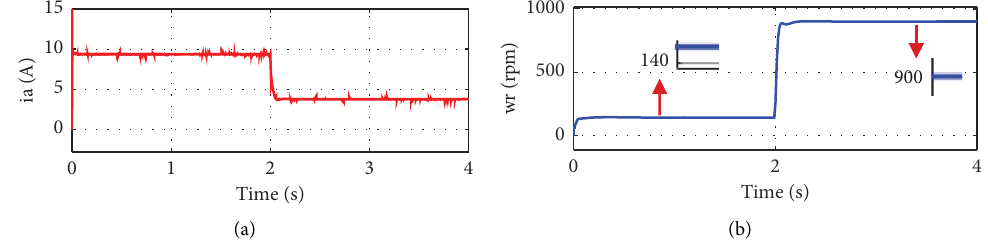
Figure 23: Series DC motor specifcation in the second mode. (a) Armature current and (b) speed of DC motor